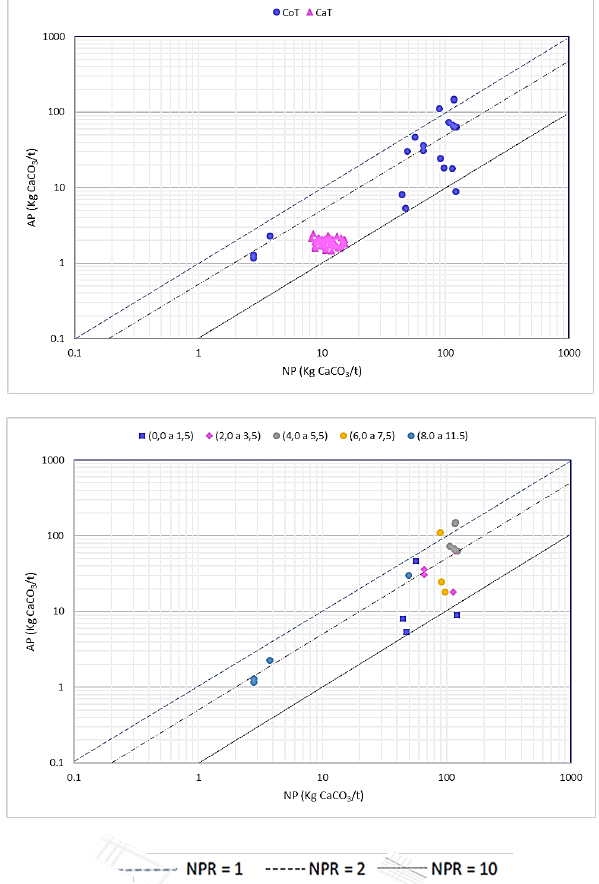
Figure 7. Results of Modified Acid-Base Accounting (MABA) tests ( a ) global and ( b ) for CoT, by sampling